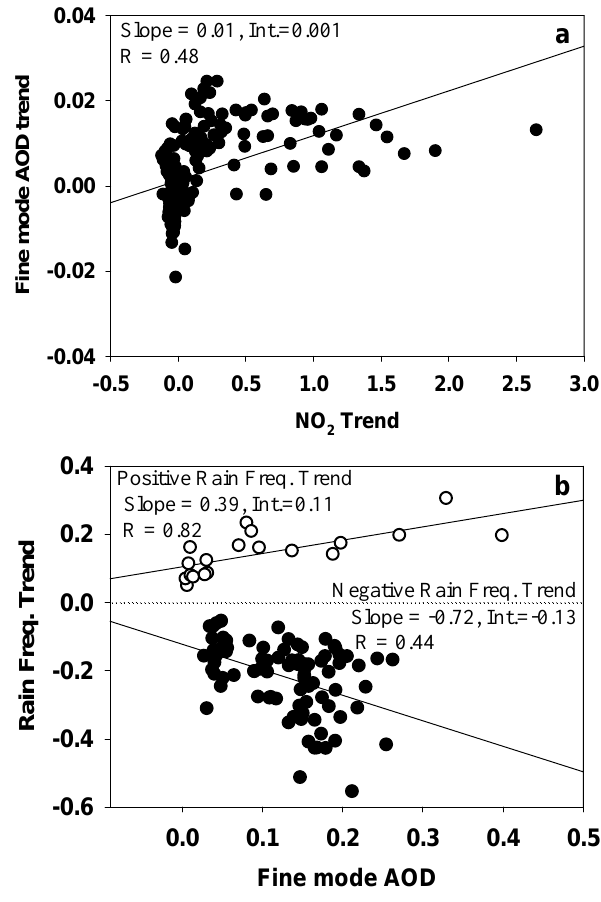
Fig. 6. (a) Scatter plot of the NO 2 column concentration trends and the fine AOD trend; (b) Scatter plot of the rain frequency trend and the fine